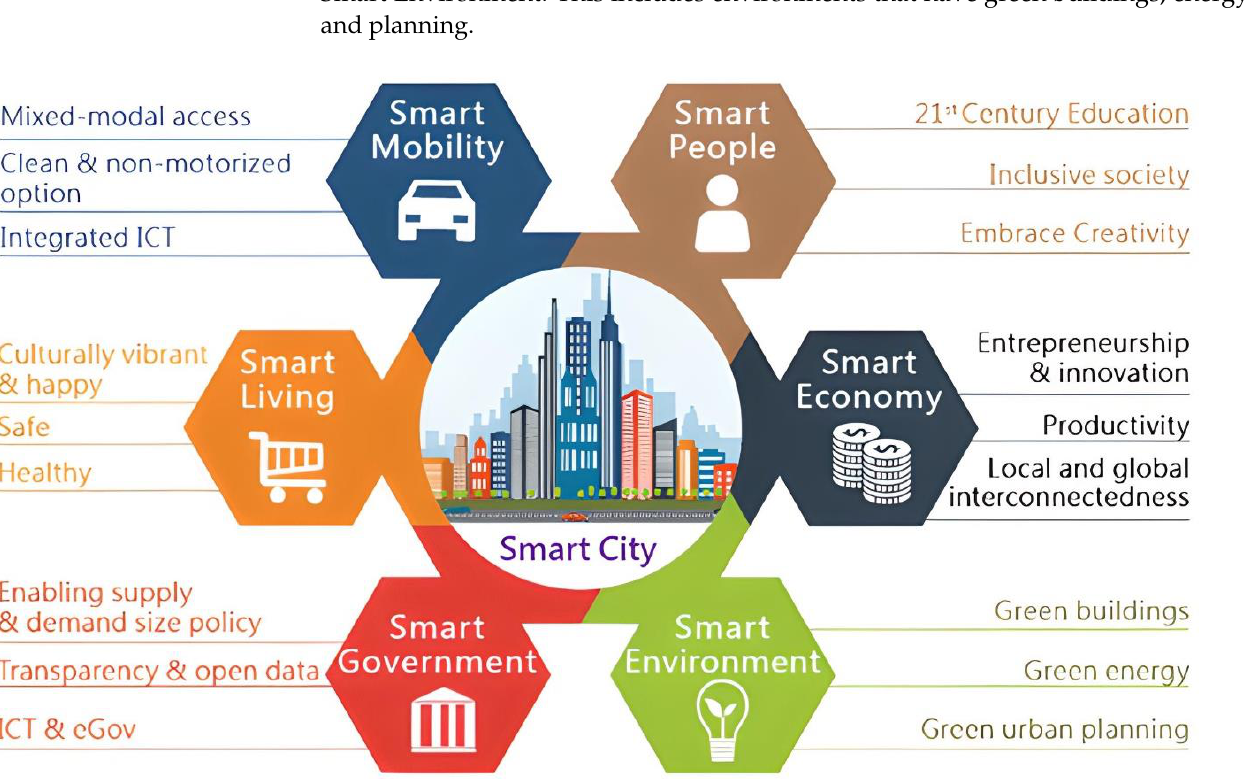
Figure 5. SDG and Smart